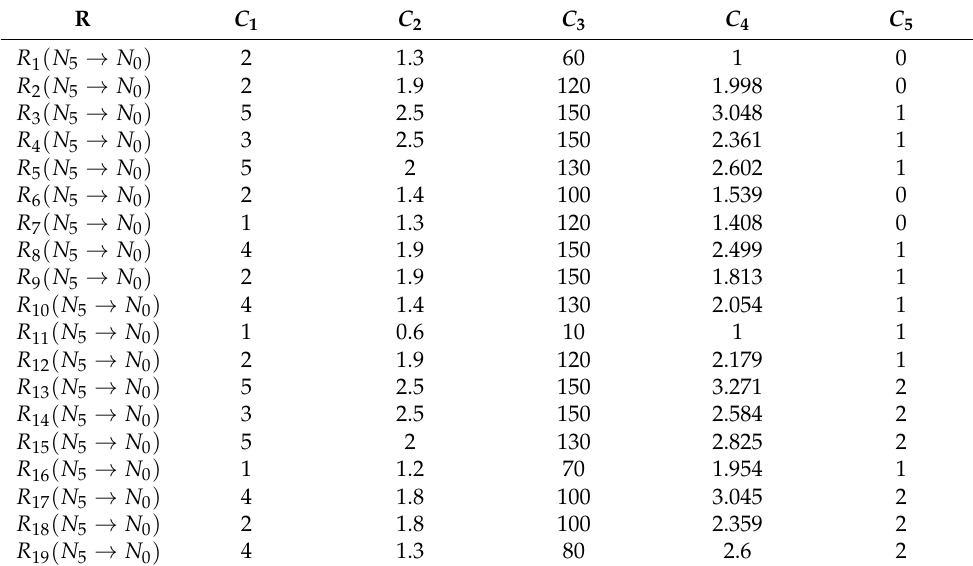
Table 4. The criteria values for the N 5 → N 0